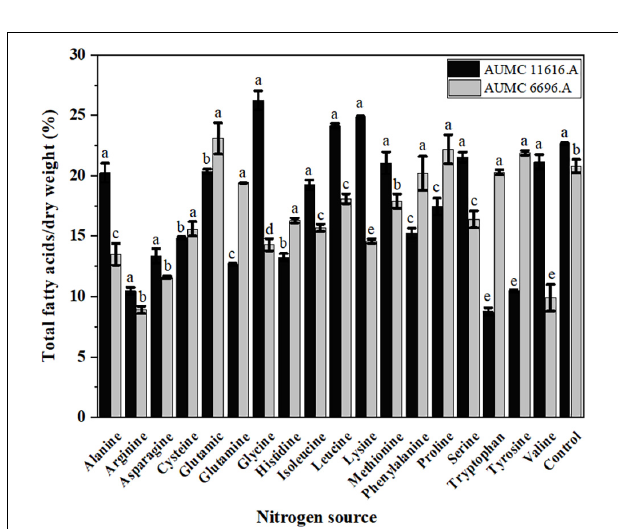
FIGURE 5 | Total fatty acids (TFAs) production of R. pusillus AUMC 11616.A and M. circinelloides AUMC 6696.A strains grown at 30 ◦ C for 4 days, on different nitrogen sources. Ammonium tartrate was employed as the control. Error bars represent the average standard deviation from three biological replicates. Values that show different superscripts were significantly different from each other using t -test ( p < 0.05).